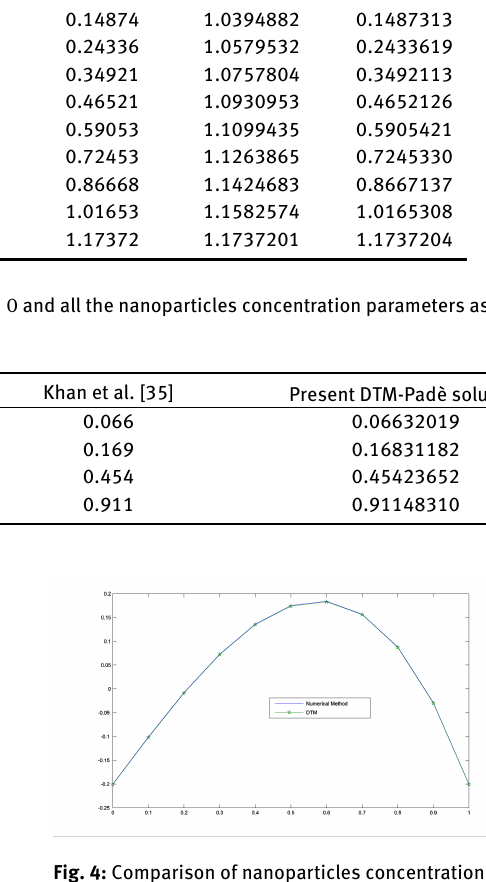
Fig. 4: Comparison of nanoparticles concentration profile with RK4 and 20 th order DTM-Padè solution